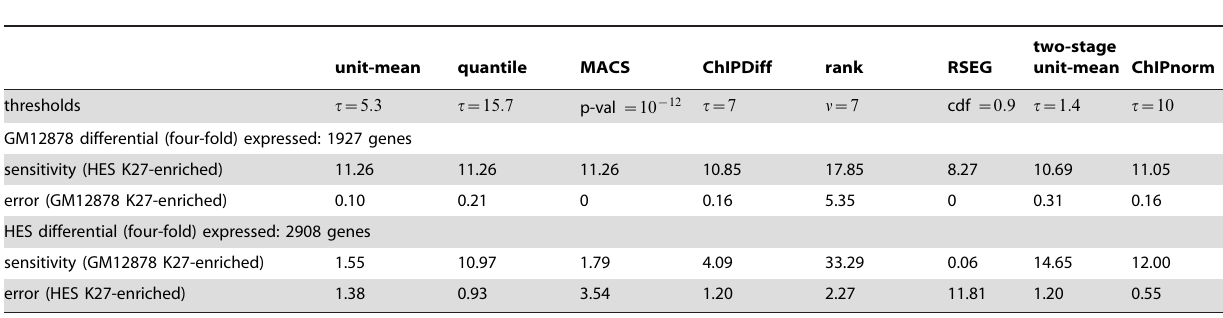
Table 2. Sensitivity analysis for human ES and GM12878 cells (replicate 1 data from ENCODE Broad database) percentages using various